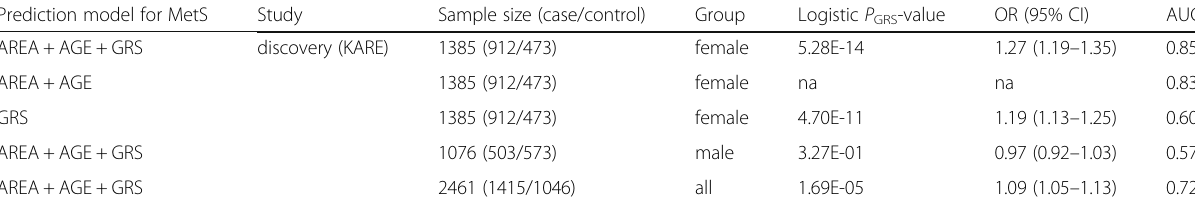
Table 4 Logistic regression models for MetS using female-specific GRS Prediction model for MetS